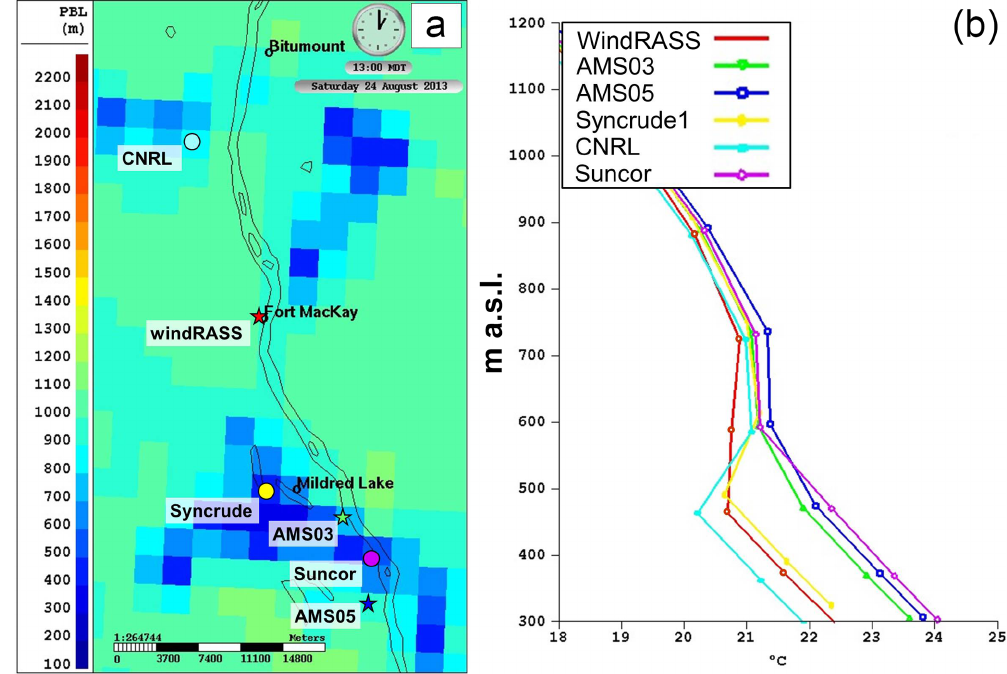
Figure 2. Examination of meteorological heterogeneity in the study area. (a) PBL heights (locations of large emitting stacks shown as circles and meteorological observation sites as stars). (b) Predicted temperature profiles at these locations and times; symbols indicate locations of model levels (a terrain-following coordinate system is used in GEM-MACH).